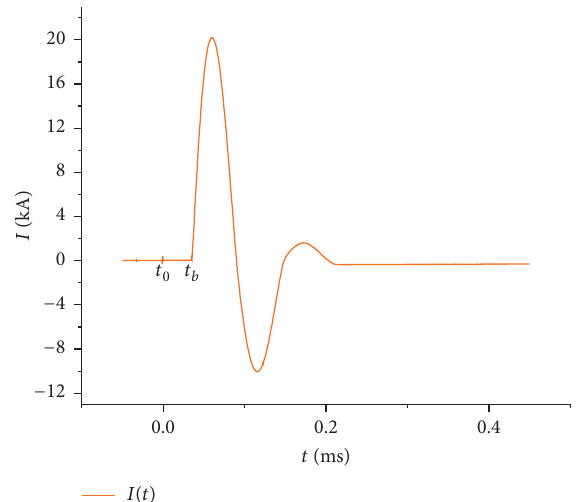
Figure 8: Time history curve of the discharge current 𝐼(𝑡) .